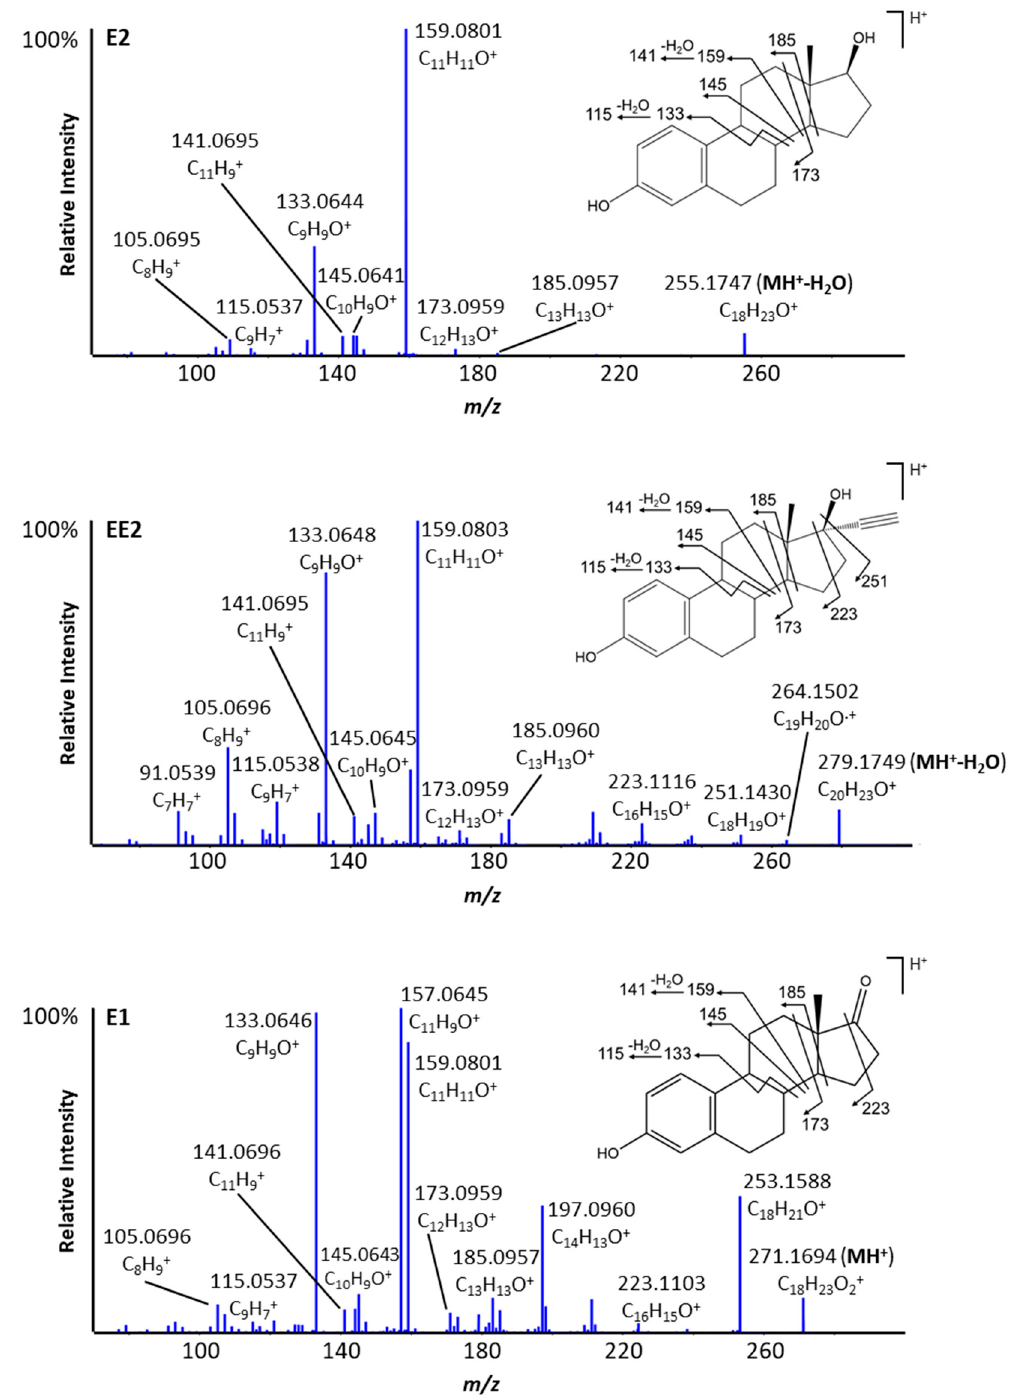
Figure 3. High-resolution MS/MS spectra of protonated ions of E2-H 2 O, EE2-H 2 O and E1 with annotated fragment ions, including mass accuracies (ppm).